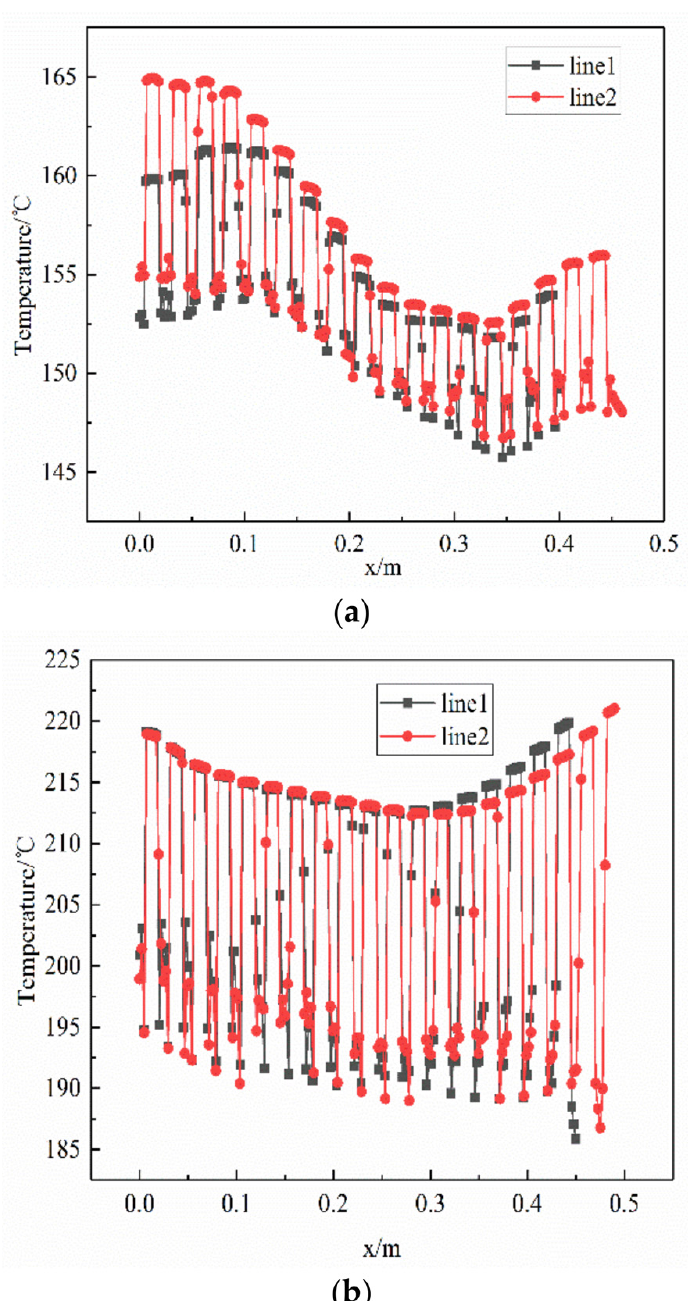
Figure 19. Wall fluid temperature distribution of the tube bundle: ( a ) the first tube side and ( b ) the second tube